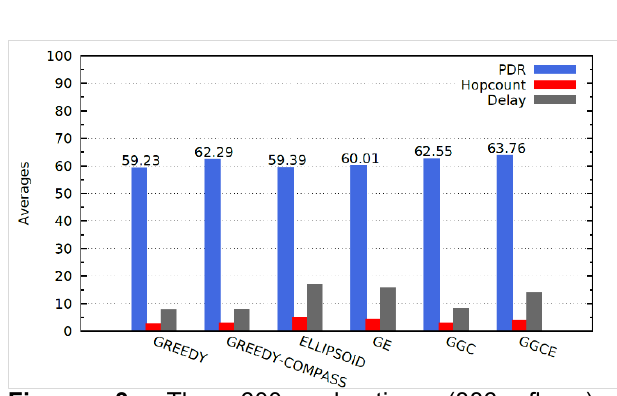
Figure 3. The 600s duration (886 flows) performances for the greedy and the multi-greedy forwarding methods.